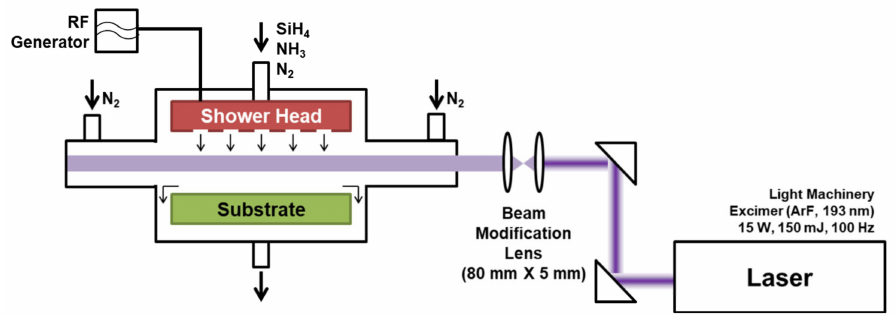
Figure 1. Schematic illustration of experimental setup for laser assisted plasma enhanced chemical vapor deposition (LAPECVD) of SiN x thin